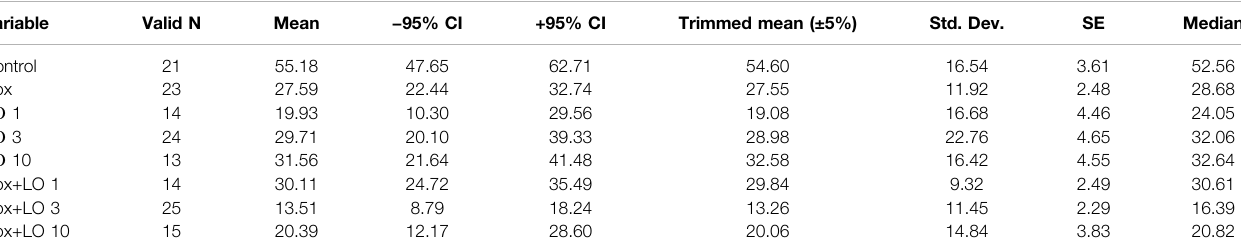
TABLE 1 | Descriptive statistics for the studied groups of animals according to values on the volume of PLS tumors after 11 days from the start of treatment. Variable Valid N Mean − 95% CI +95%